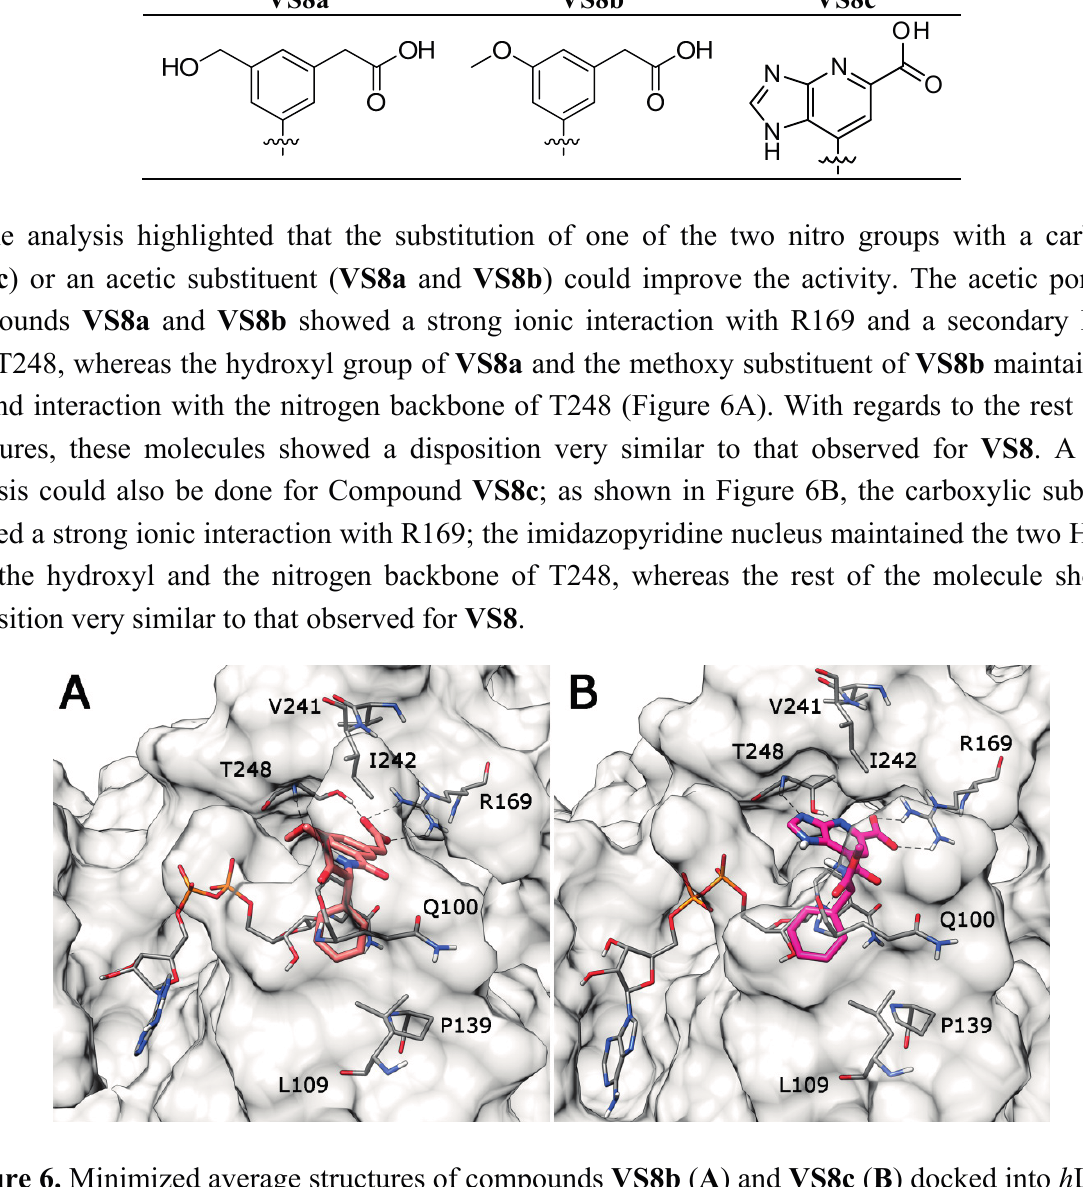
Figure 6. Minimized average structures of compounds VS8b ( A ) and VS8c ( B ) docked into h